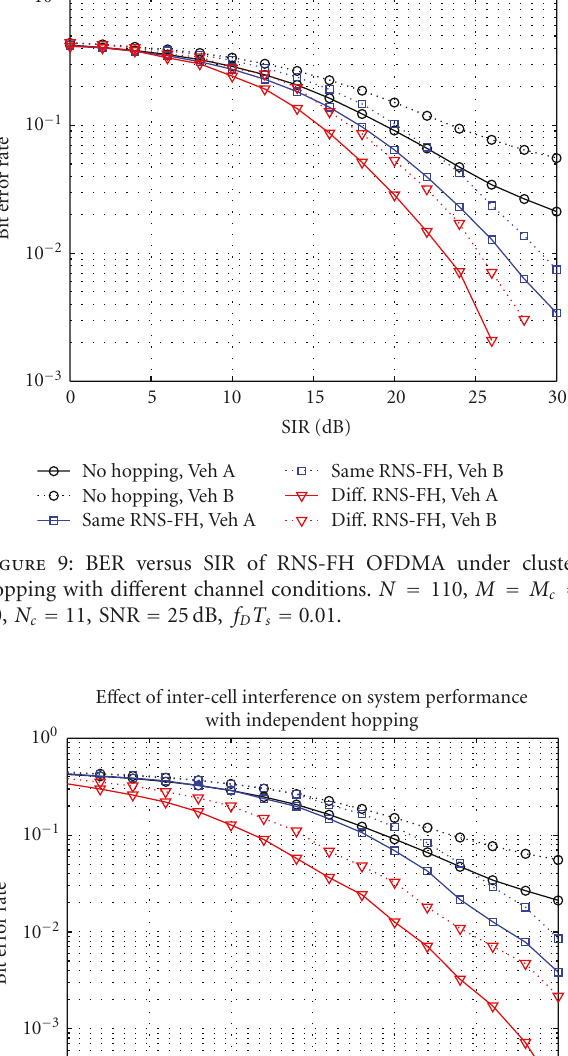
(Figure 9), with di ff erent pattern assignments, nearly 3 dB gain at a BER level of 10 − 2 is achieved relative to the system employing identical hopping. This gain grows to 5 dB under independent hopping scenario (Veh B environ-